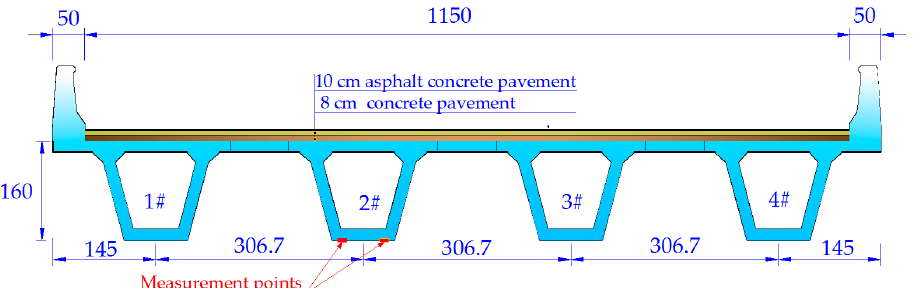
Figure 20. Cross-section dimensions of the bridge (unit: cm).